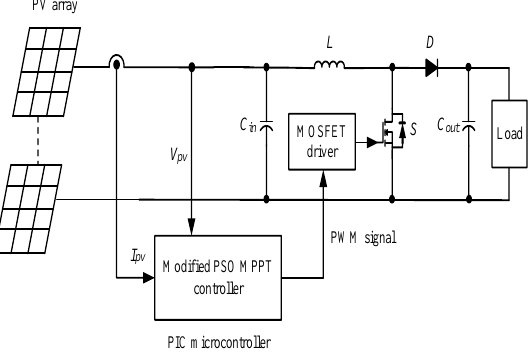
Figure 8. Framework of the maximum power point tracker of the modified PSO.